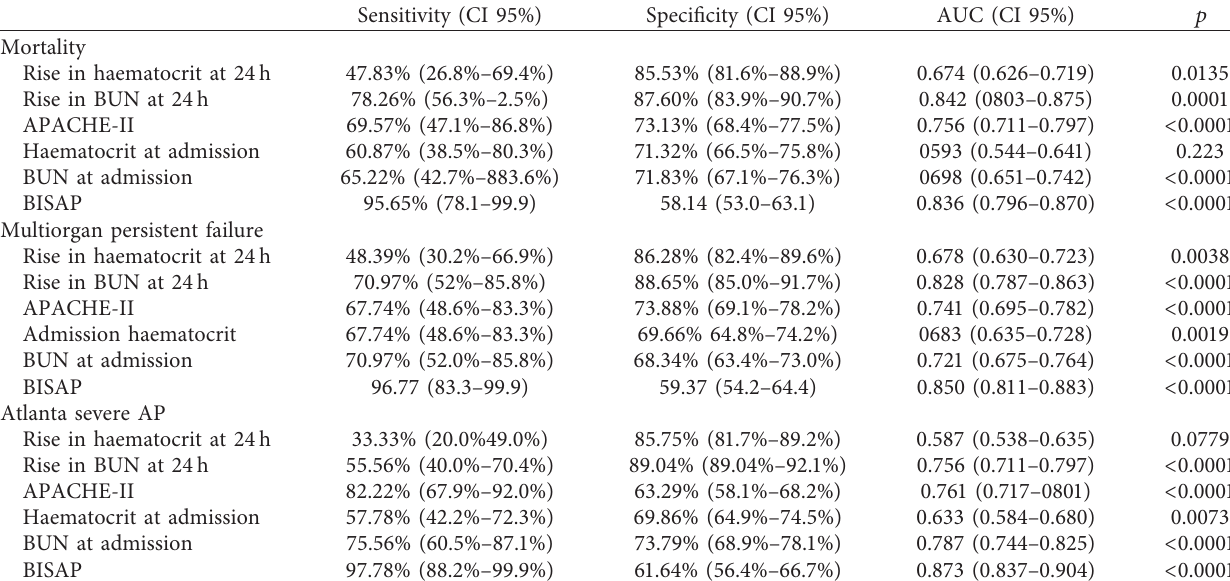
Table 3: Sensitivity, specificity, and AUC values of BISAP, APACHE-II, BUN, and haematocrit regarding mortality, persisting multiorgan failure, and severe AP.